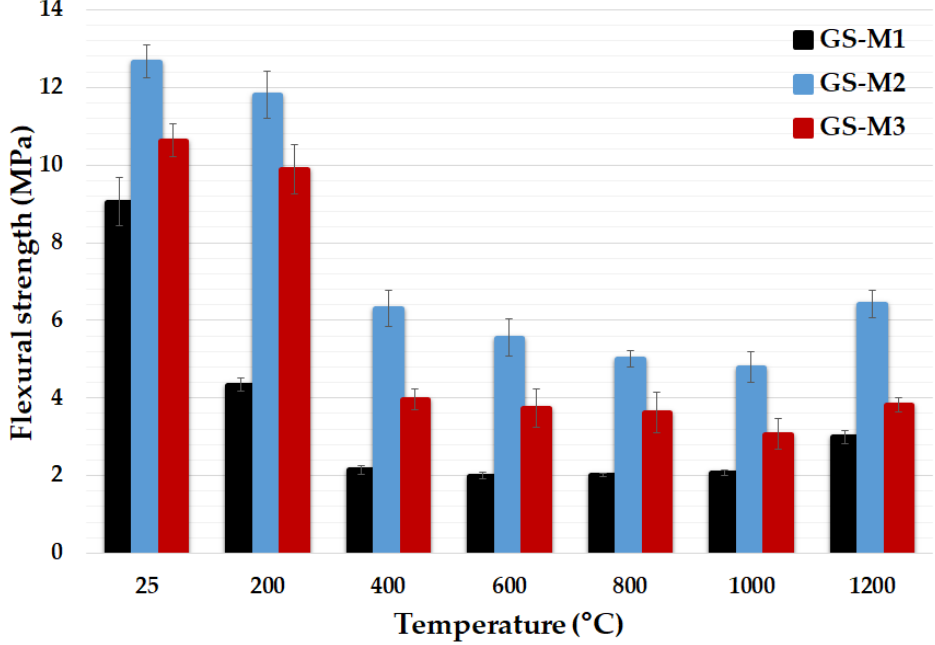
Figure 9. Flexural strength of the geopolymer composites with different types of aluminosilicates at laboratory temperature and after exposure up to 1200 °C.